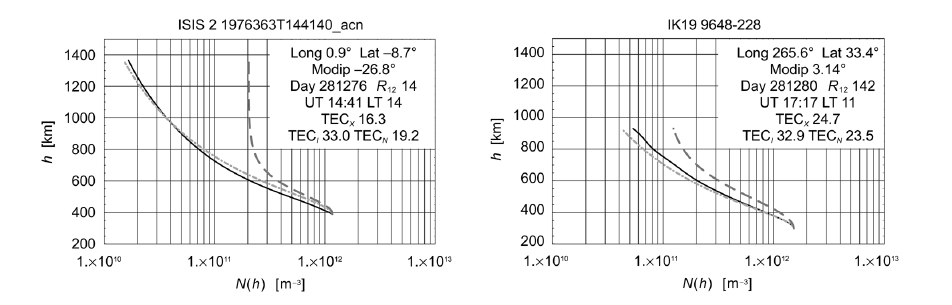
Fig. 2. Comparison between experimental profiles from ISIS2 and IK19 data and NeQuick and IRI models: ex- perimental ( X ) solid black, NeQuick ( N ) dash-dotted light gray, IRI ( I ) dashed dark gray. TEC in 10 16 m − 2 . 499